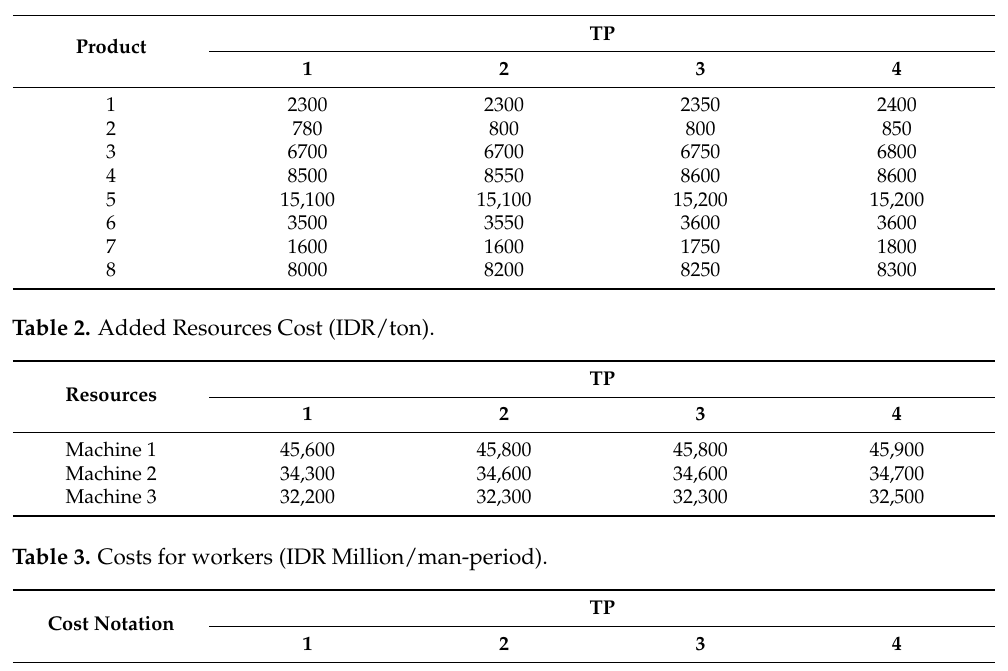
Table 1. Production Cost (IDR Million/ton).